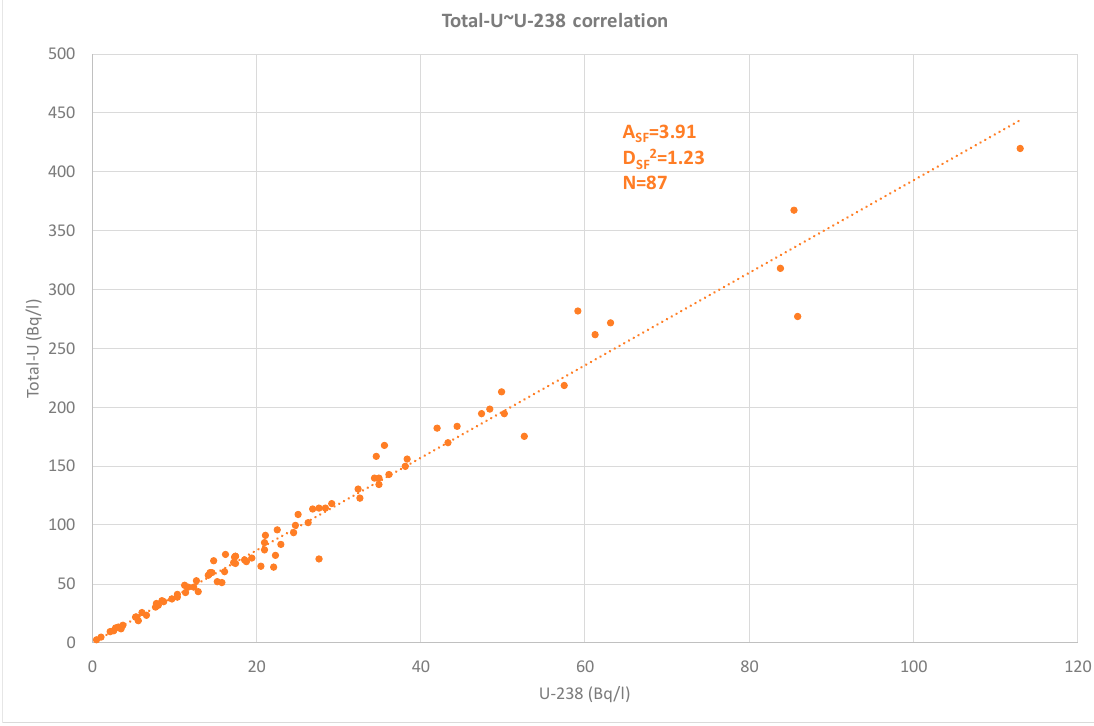
Figure 2. Total-U~U-238 correlation in the Bosco Marengo “FN” nuclear installation’s liquid effluents. On the x-axis, the concentration of U-238 as determined by alpha spectrometry [10], on the y-axis, the sum of the concentrations of U-238, U-234, and U-235, also determined by alpha spectrometry. The scaling factor A SF is the slope of the line shown in the graph.